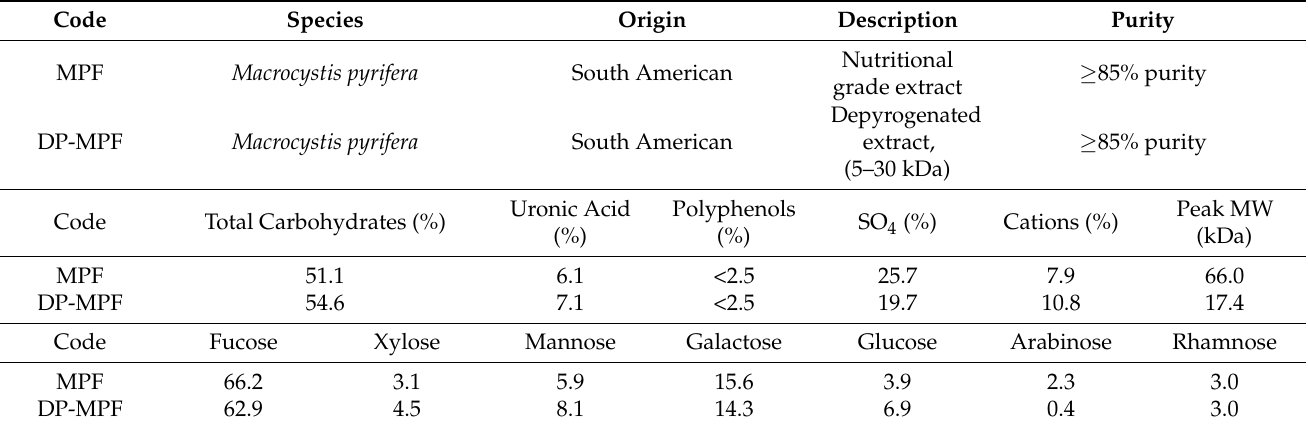
Table 1. The composition and carbohydrate profile of fucoidan extracts (MPF and